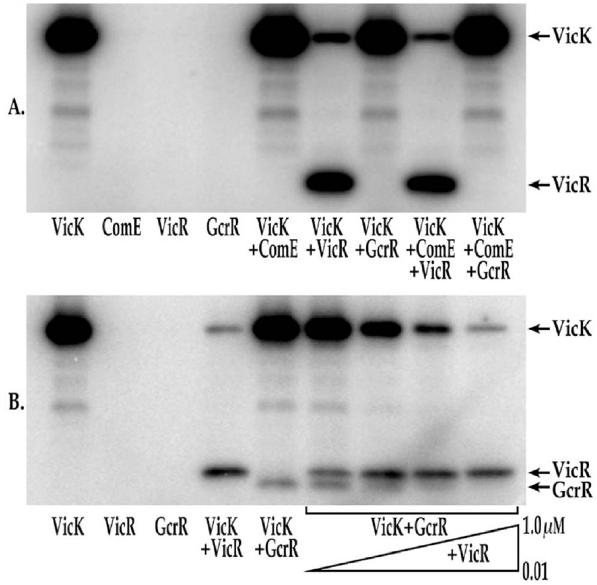
Fig. 3. in vitro transphosphorylation of VicR and GcrR by VicK. A) Phosphorylation of VicR and GcrR by VicK in the presence of MgCl 2 . For each reaction 1 m M of each of the following proteins were included in the reaction: Lane 1: VicK; Lane 2: ComE; Lane 3: VicR; Lane 4: GcrR; Lane 5: VicK and ComE; Lane 6: VicK and VicR; Lane 7: VicK and GcrR; Lane 8: VicK, ComE and VicR; Lane 9: VicK, ComE and GcrR. B) Phosphorylation of VicR and GcrR by VicK in the presence of MnCl 2 . For each reaction 1 m M of each of the following proteins were included in the reaction unless otherwise indicated: Lane 1: VicK; Lane 2: VicR; Lane 3: GcrR; Lane 4: VicK and VicR; Lane 5: VicK and GcrR; Lane 6: VicK, GcrR and 0.01 m M VicR; Lane 7: VicK, GcrR and 0.02 m M VicR; Lane 8: VicK, GcrR and 0.04 m M VicR; Lane 9: VicK, GcrR and 1 m M VicR. The gels shown are a representative set of replicate gels run for each